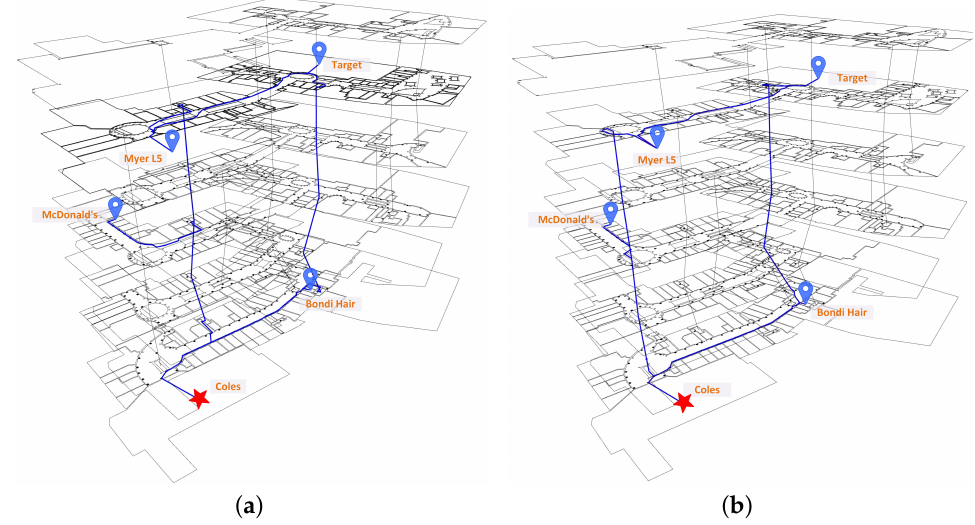
Figure 10. The ITSP path tests on multi-floors. The red star represent the departure location, the blue location tags mark the shops that the customer is interested. ( a ) Only Lifts; ( b ) Stairs, escalators, and